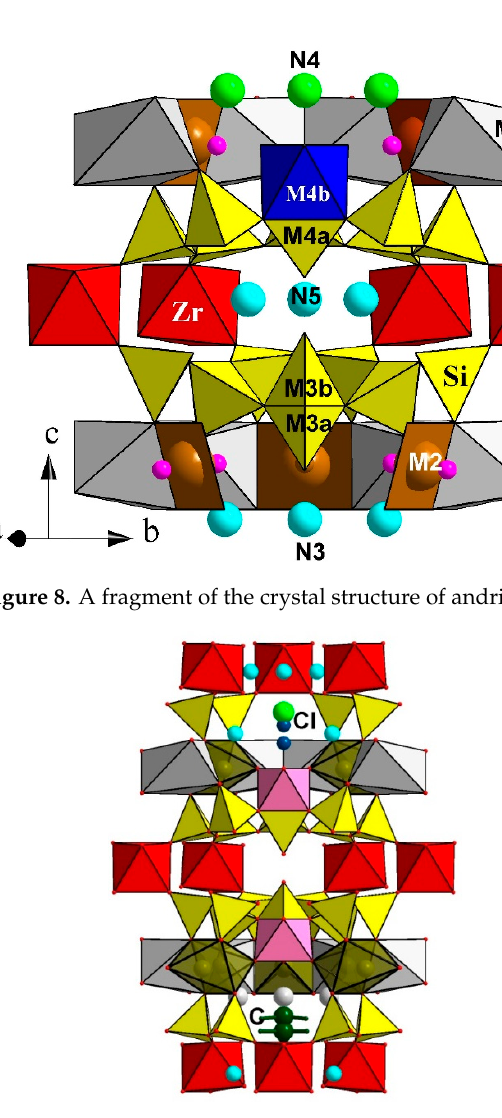
Figure 7. A fragment of the crystal structure of davinciite.